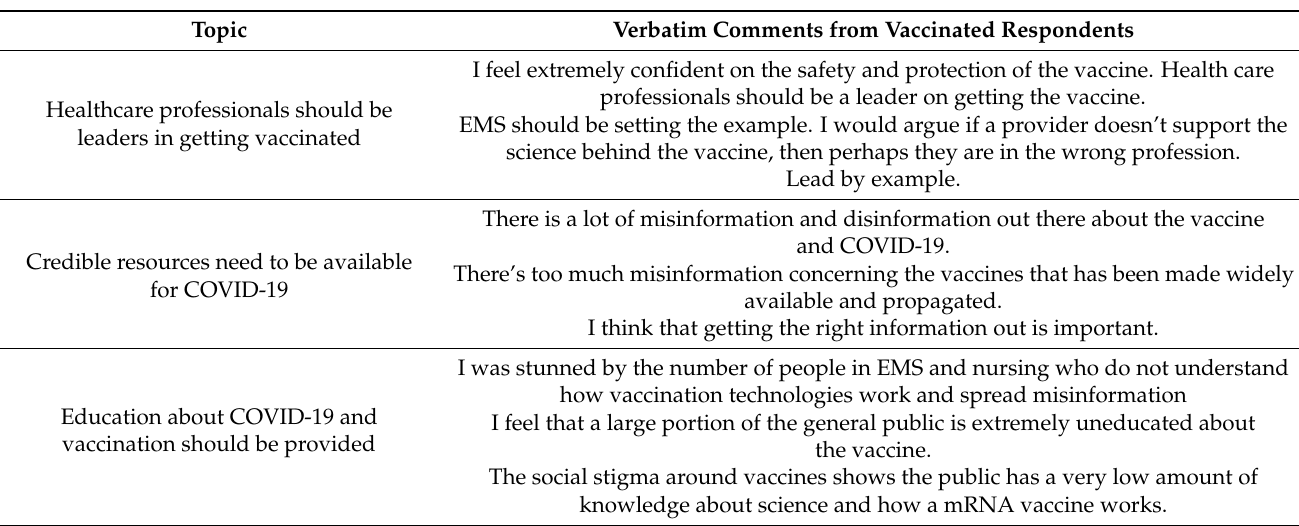
Table 4. Opportunities to promote